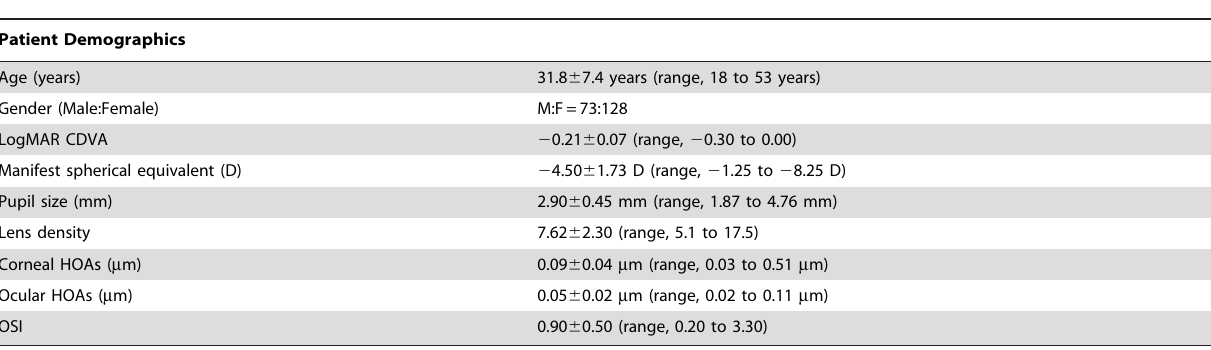
Table 1. Demographics of the study